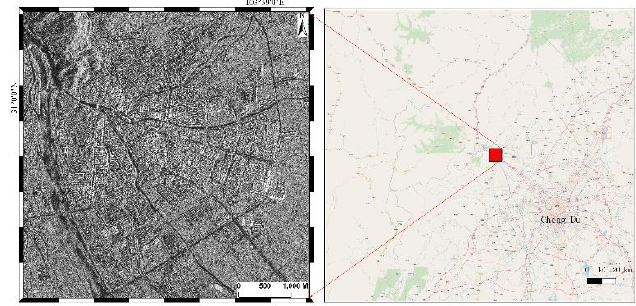
Figure 7. TerraSAR-X data used in study and study